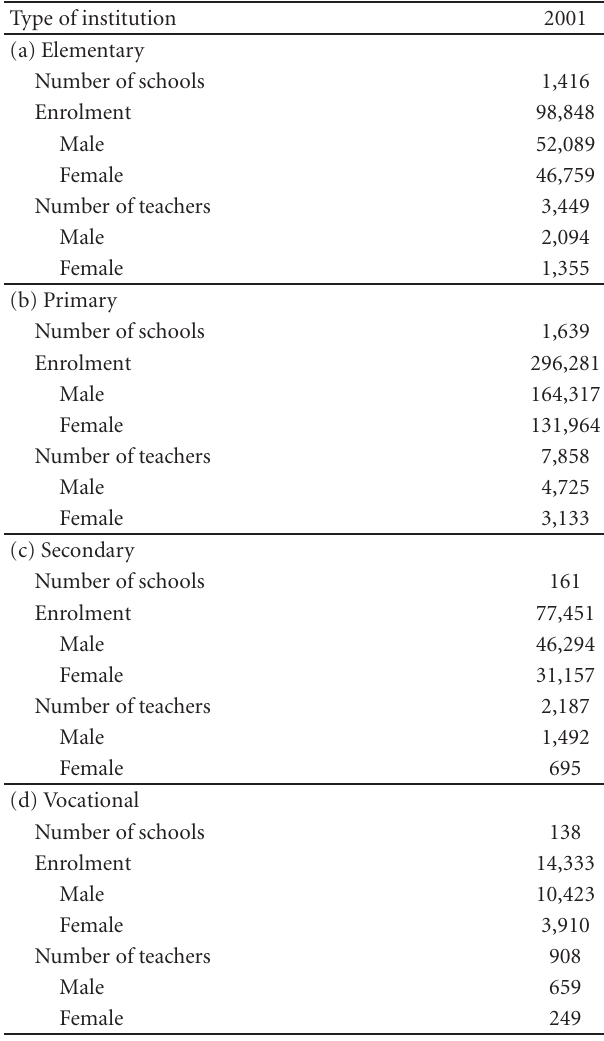
Table 2: Enrolment, number of schools, and teachers,